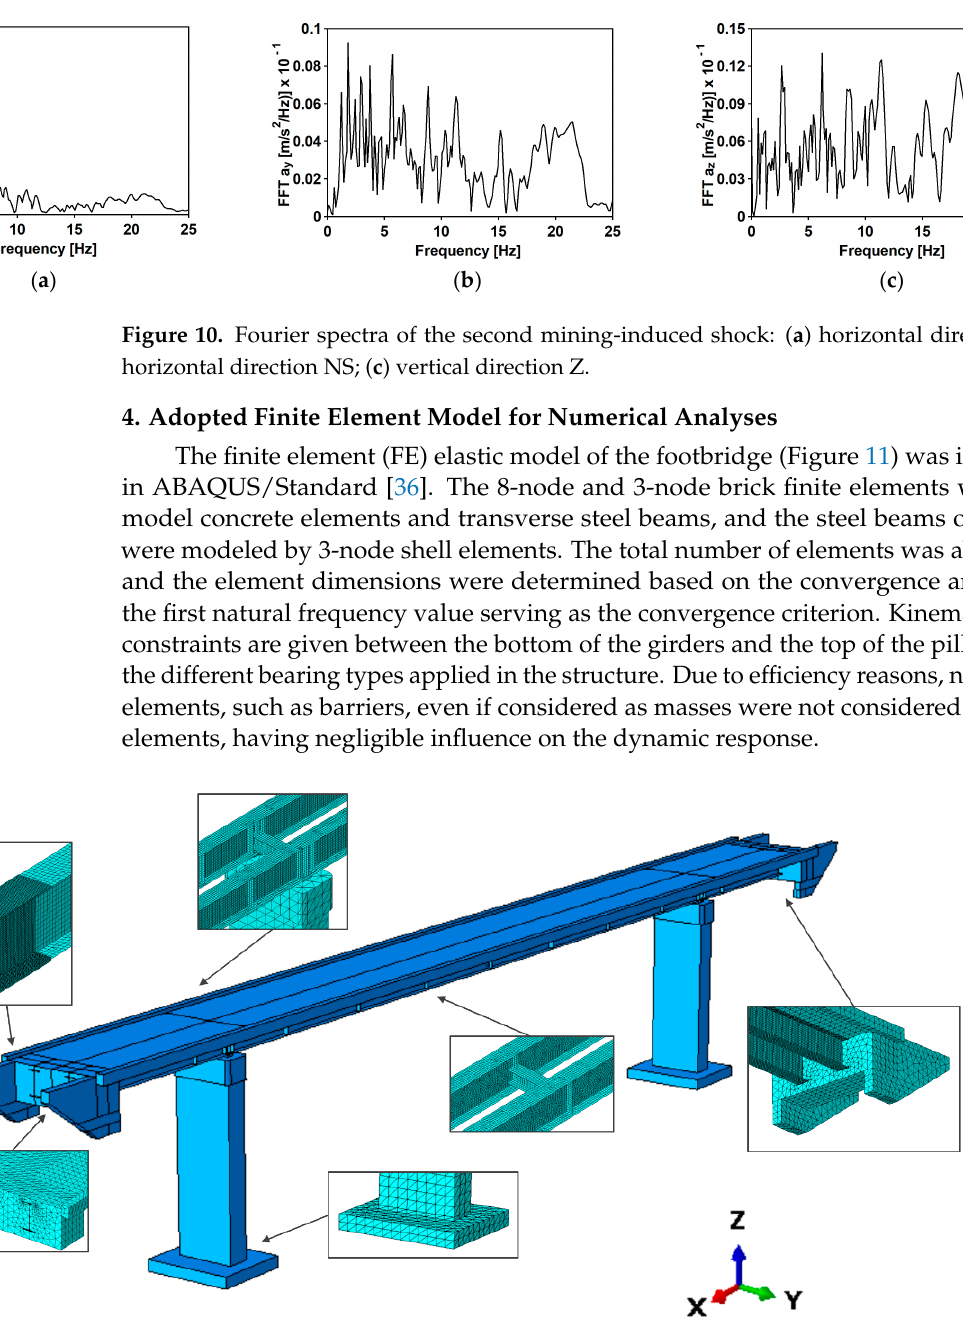
shock: ( a ) horizontal direction WE; ( b ) horizontal direction NS; ( c ) vertical direction Z.